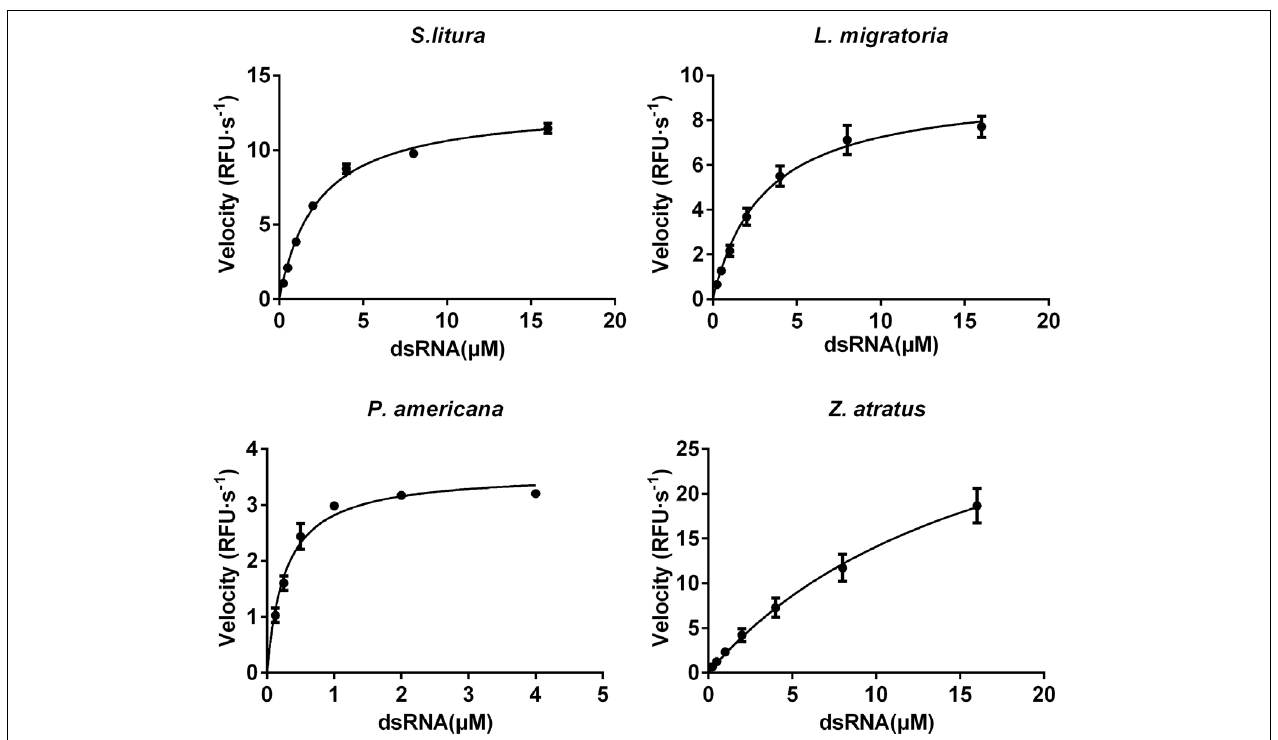
FIGURE 8 | Comparison of the saturation curves of the dsRNA degrading nuclease of four insects. The homogenates were prepared from whole body of different insects. The test reaction used the buffer with optimal pH and Mg 2 + concentrations for different insect species (pH 10.0 and 8 mM Mg 2 + for S. litura , pH 9.0 and 8 mM Mg 2 + for the other three species). Different concentration of dsRNA substrates were incubated with 19 µ L enzyme solutions in a total volume of 20 µ L. The fluorescence intensity in different reactions were continuously monitored at 37 ◦ C. Values are mean ± SE; n =